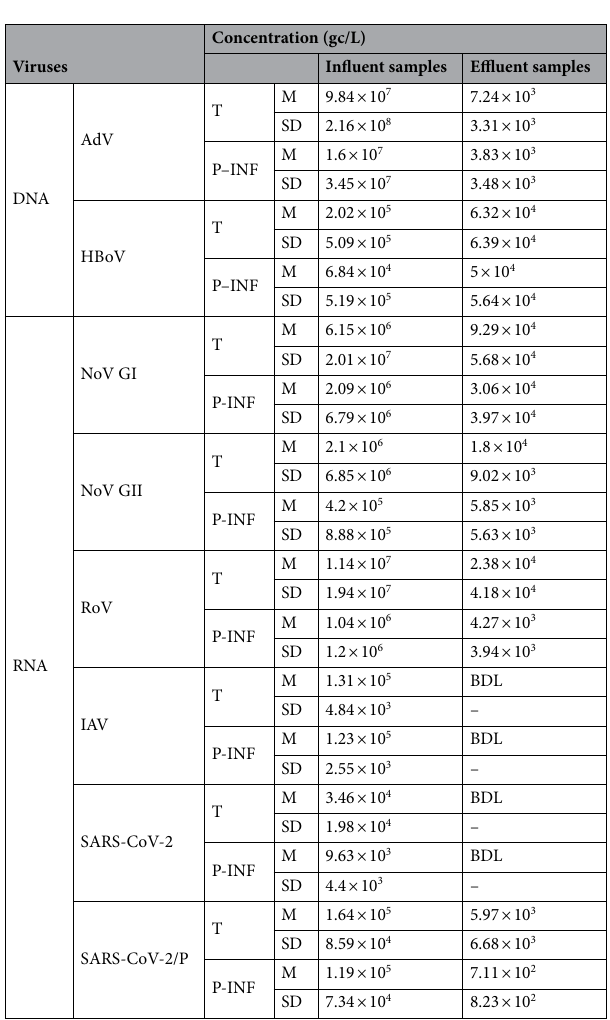
Table 8. The concentrations of DNA and RNA viruses (gc/L) in positive influent and effluent wastewater samples. T total concentration of viruses, P‑INF concentration of potentially infectious viruses, M